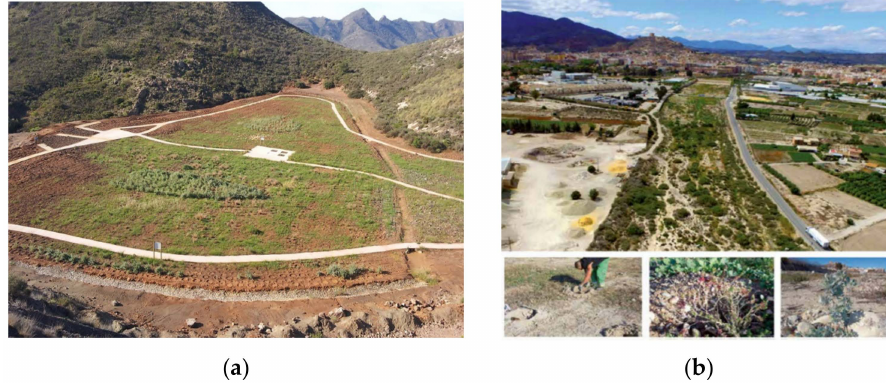
Figure 8. Final state of rehabilitation: ( a ) in Case Study 1, and ( b ) Case Study